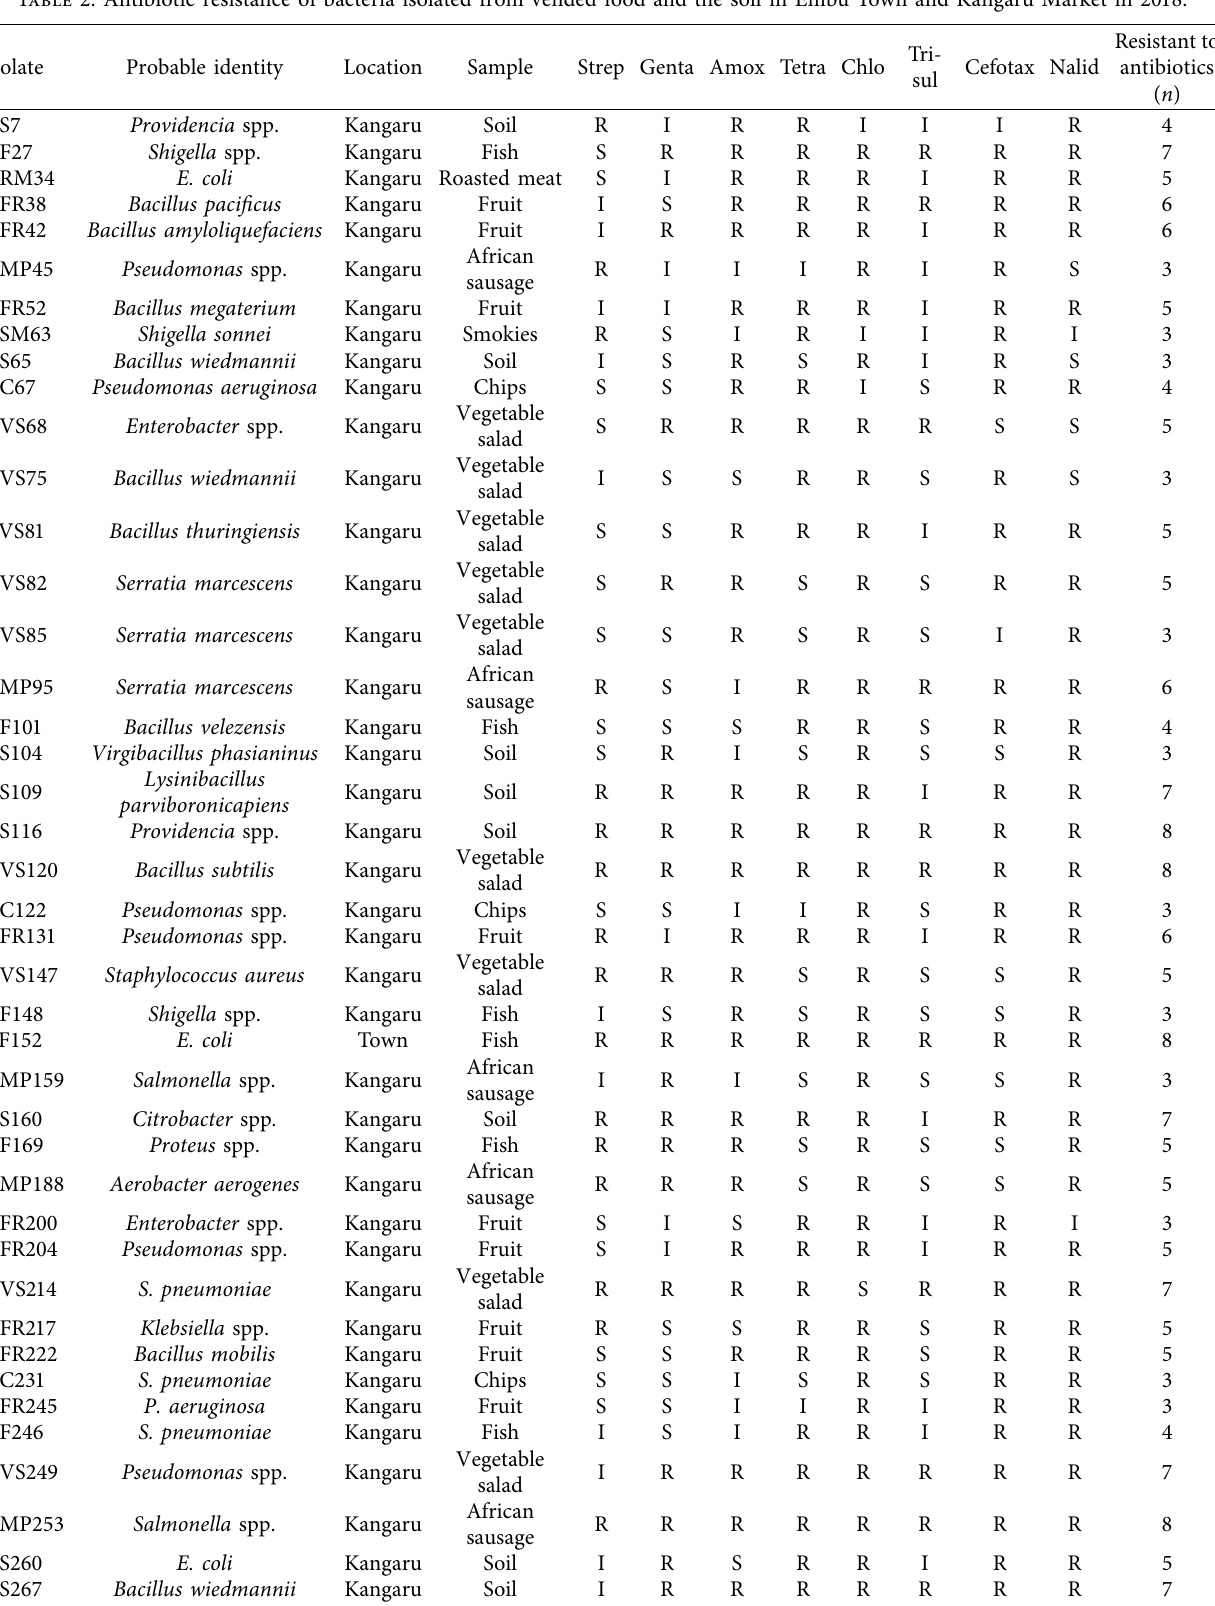
Table 2: Antibiotic resistance of bacteria isolated from vended food and the soil in Embu Town and Kangaru Market in 2018. Isolate KS7 Providencia spp.